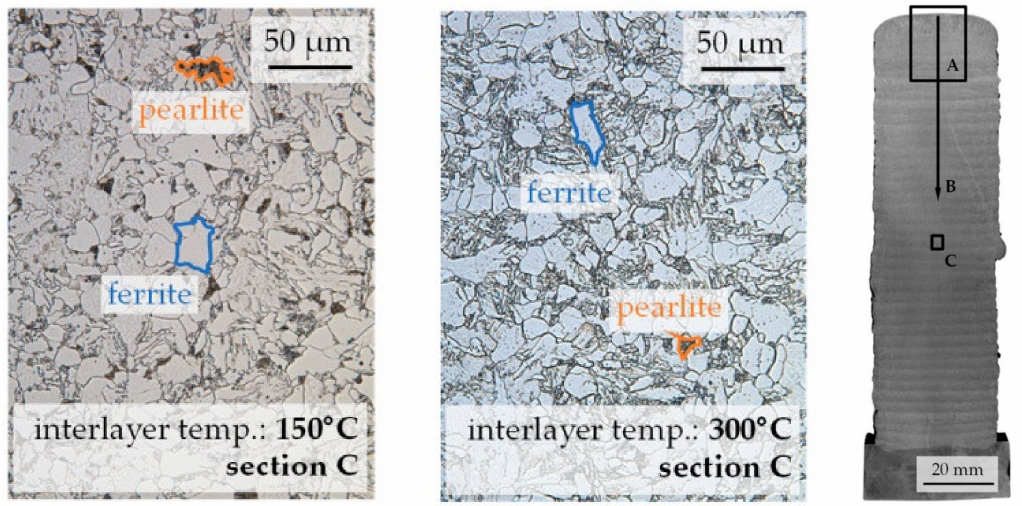
Figure 16. Micrographs of WAAM material for the interlayer [53].